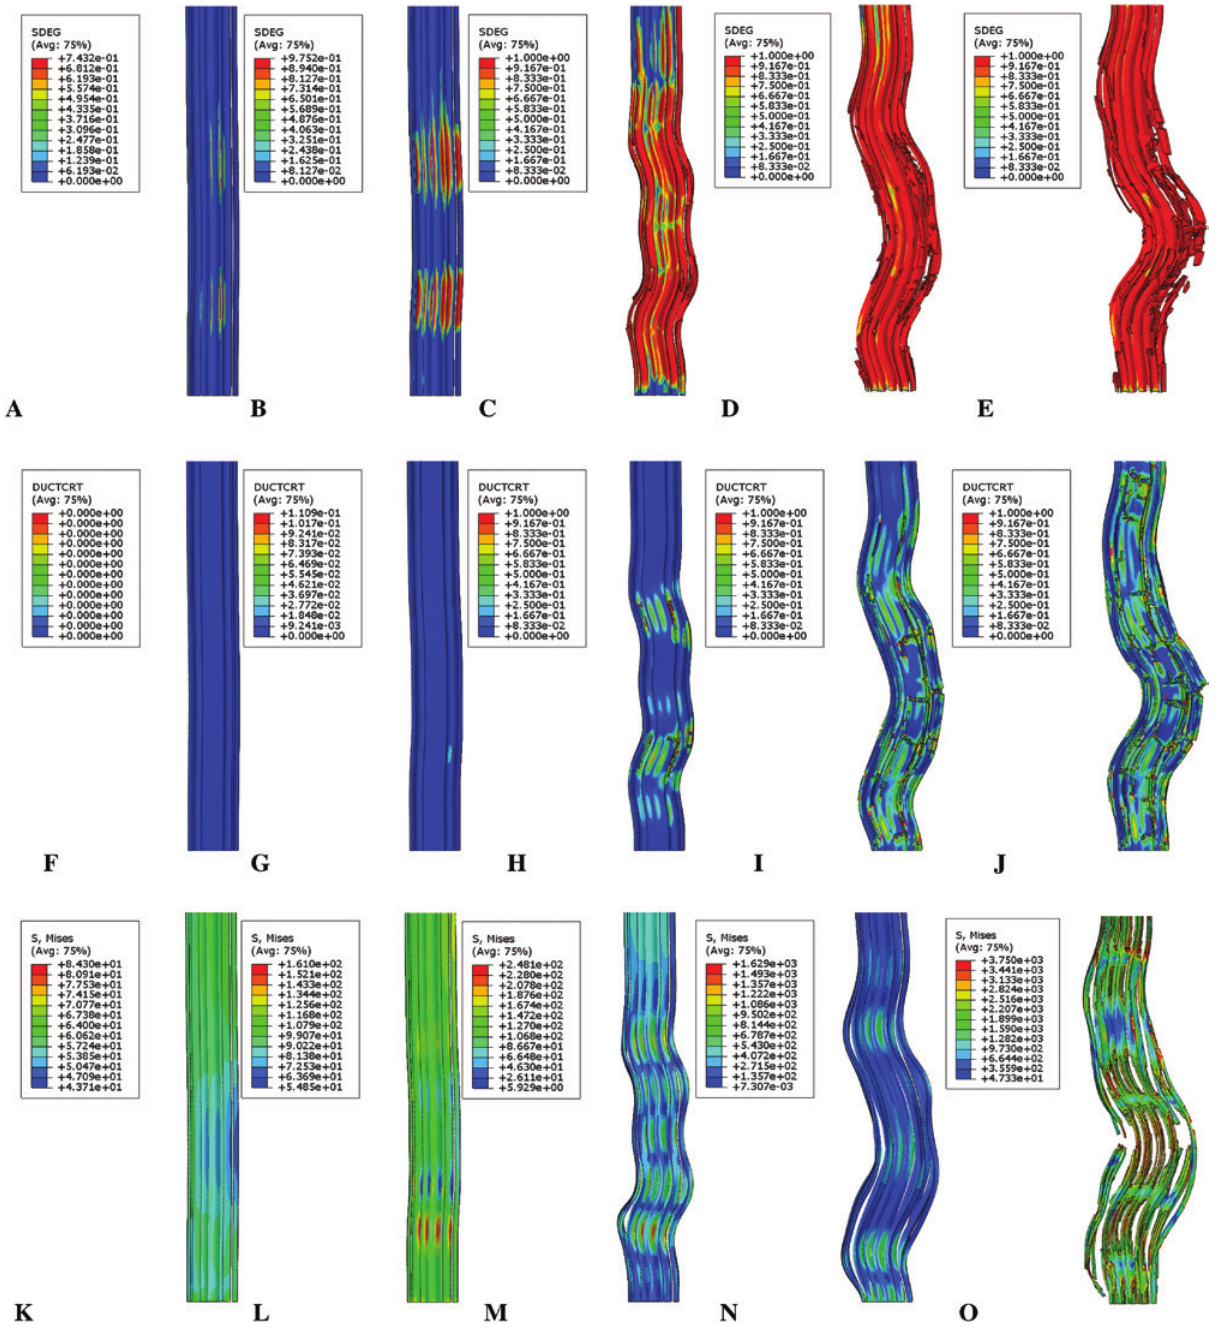
Figure 7: The deformation and progressive damage process of carbon fiber-reinforced composites under longitudinal compression. (A) Interfacial initial debonding at longitudinal compressive strain load ε = 0.55%. (B) Interfacial debonding at longitudinal compressive strain load ε = 0.69%. (C) Interfacial debonding at longitudinal compressive strain load ε = 0.82%. (D) Interfacial debonding at longitu- dinal compressive strain load ε = 0.95%. (E) Interfacial debonding at longitudinal compressive strain load ε = 1.00%. (F) Matrix damage at longitudinal compressive strain load ε = 0.55%. (G) Matrix initial damage at longitudinal compressive strain load ε = 0.69%. (H) Matrix damage at longitudinal compressive strain load ε = 0.82%. (I) Matrix damage at longitudinal compressive strain load ε = 0.95%. (J) Matrix damage at longitudinal compressive strain load ε = 1.00%. (K) Fiber micro-bulking and stress distribution at longitudinal compressive strain load ε = 0.55%. (L) Fiber micro-bulking and stress distribution at longitudinal compressive strain load ε = 0.69%. (M) Fiber micro- bulking and stress distribution at longitudinal compressive strain load ε = 0.82%. (N) Fiber micro-bulking and stress distribution at longitudinal compressive strain load ε = 0.95%. (O) Fiber micro-bulking and stress distribution at longitudinal compressive strain load ε =